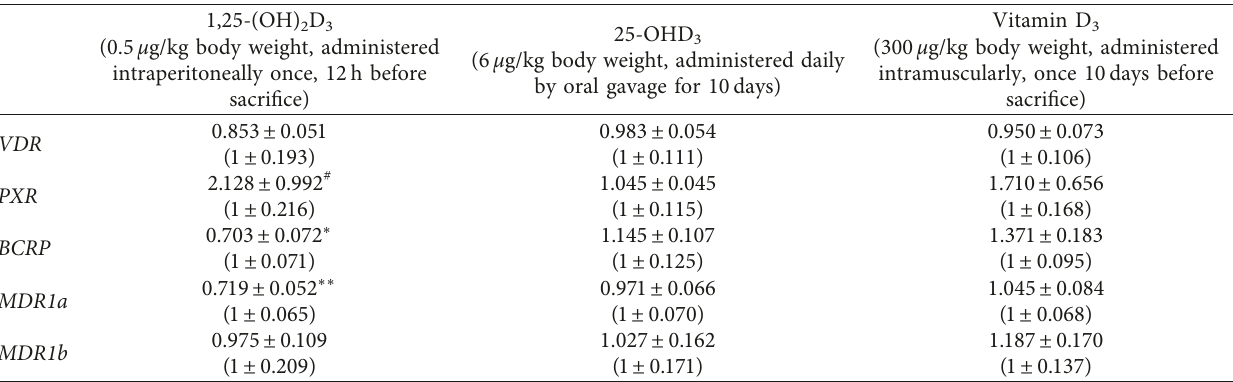
Table 7: RNA expression in the brain of rats treated with different vitamin D metabolites normalized to GAPDH.